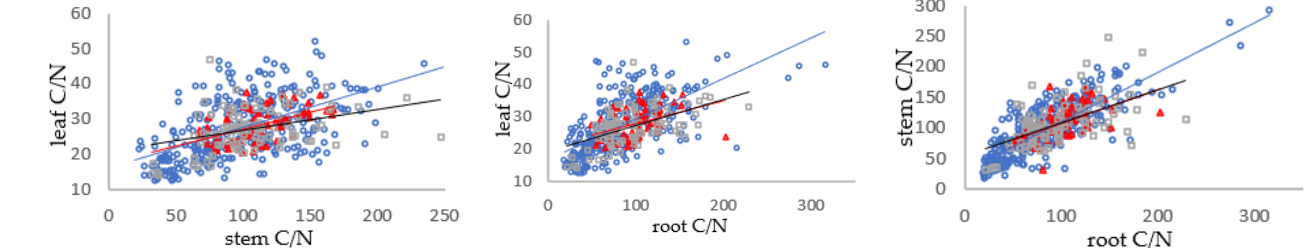
Figure 4. The relationship between the ratio of C, N, and P in roots for different mycorrhizal types. The blue cycles and blue lines mean AM, the red triangles and red lines mean AM + ECM, and the gray squares and black lines mean ECM.